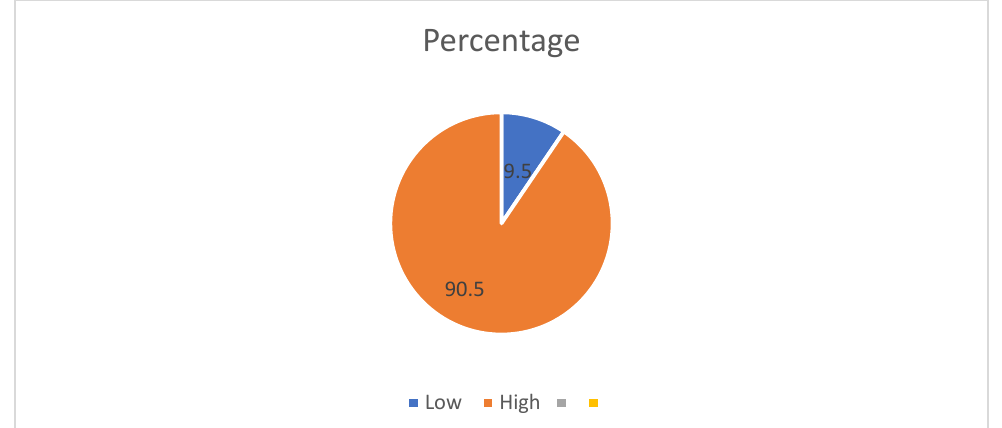
Figure 1. Status/Level of Use of Climate Smart Small Ruminant Production Practices among